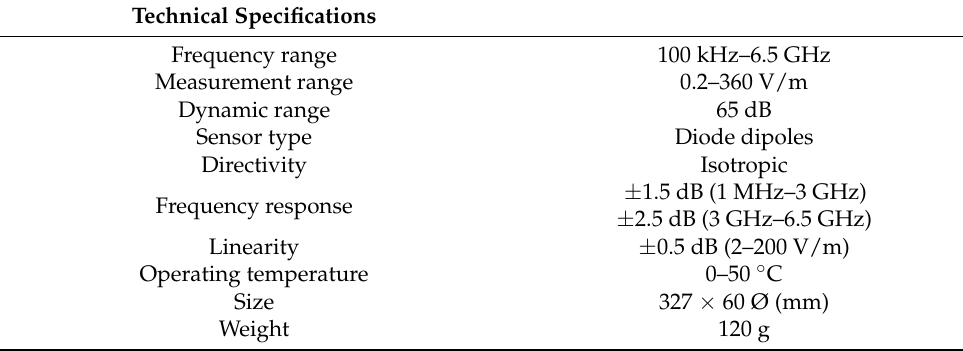
Table 2. The technical parameters of the probe [30].